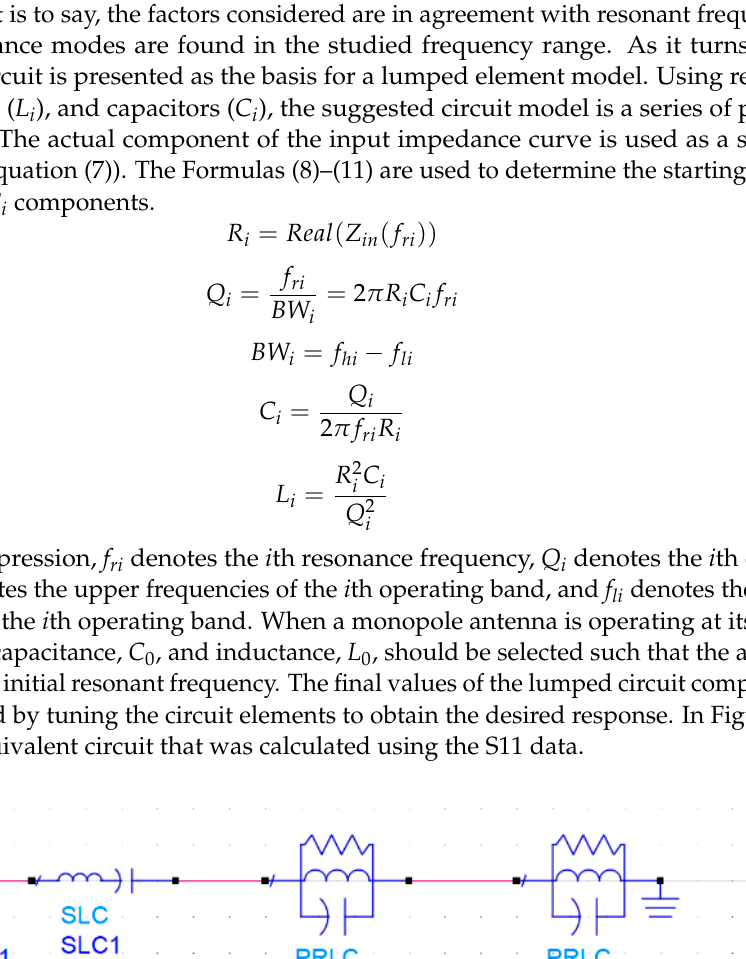
Figure 3 . ( a ) Comparison of the SPICE equivalent circuit based on impedance and CST S11 results ; ( b ) comparison of the resulting impedance from CST and equivalent circuit.